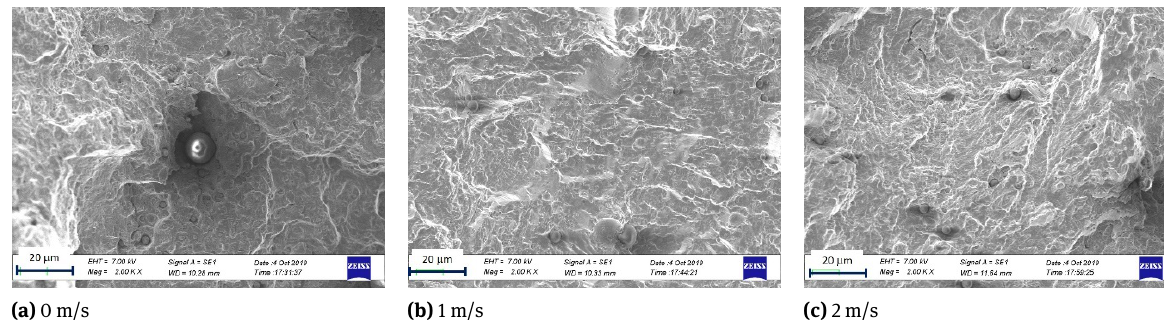
Figure 13: Fatigue fracture surface of underwater wet welding in water depth of 5 m.